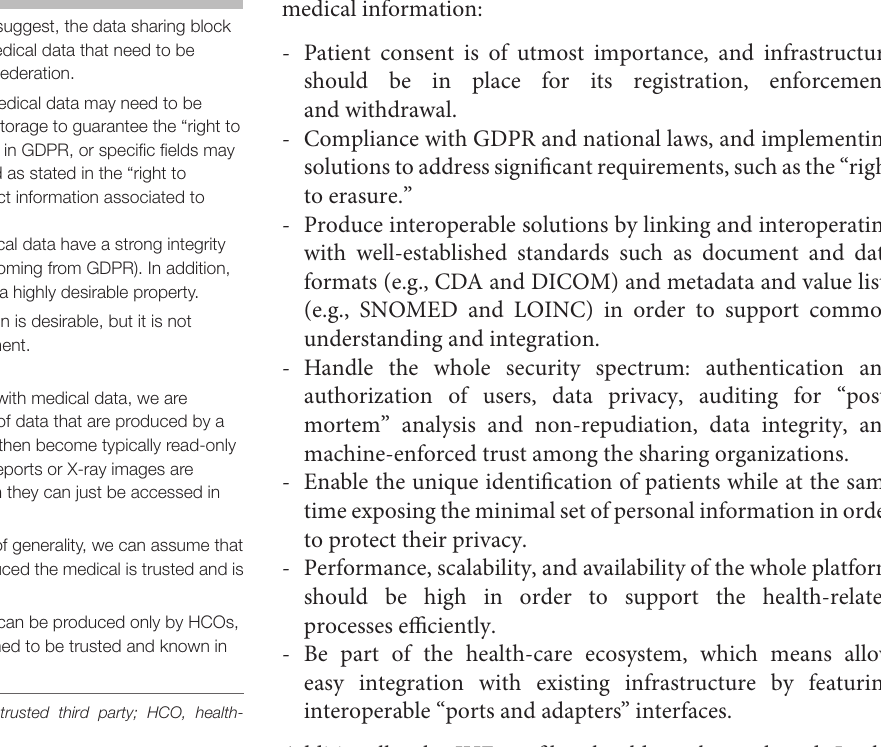
TABLE 3 | Assessment of blockchain for data sharing operations. DATA